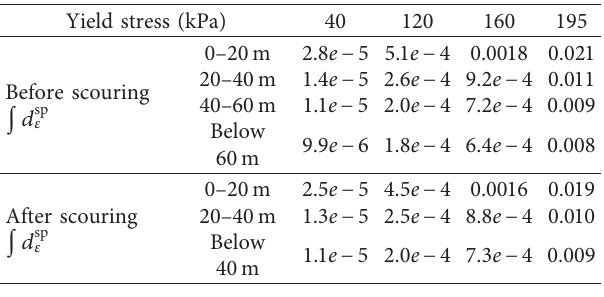
Figure 5: Absorption of S and P waves at the sponge boundary. Table 1: Yield stresses and corresponding plastic strains at different embedded depths.